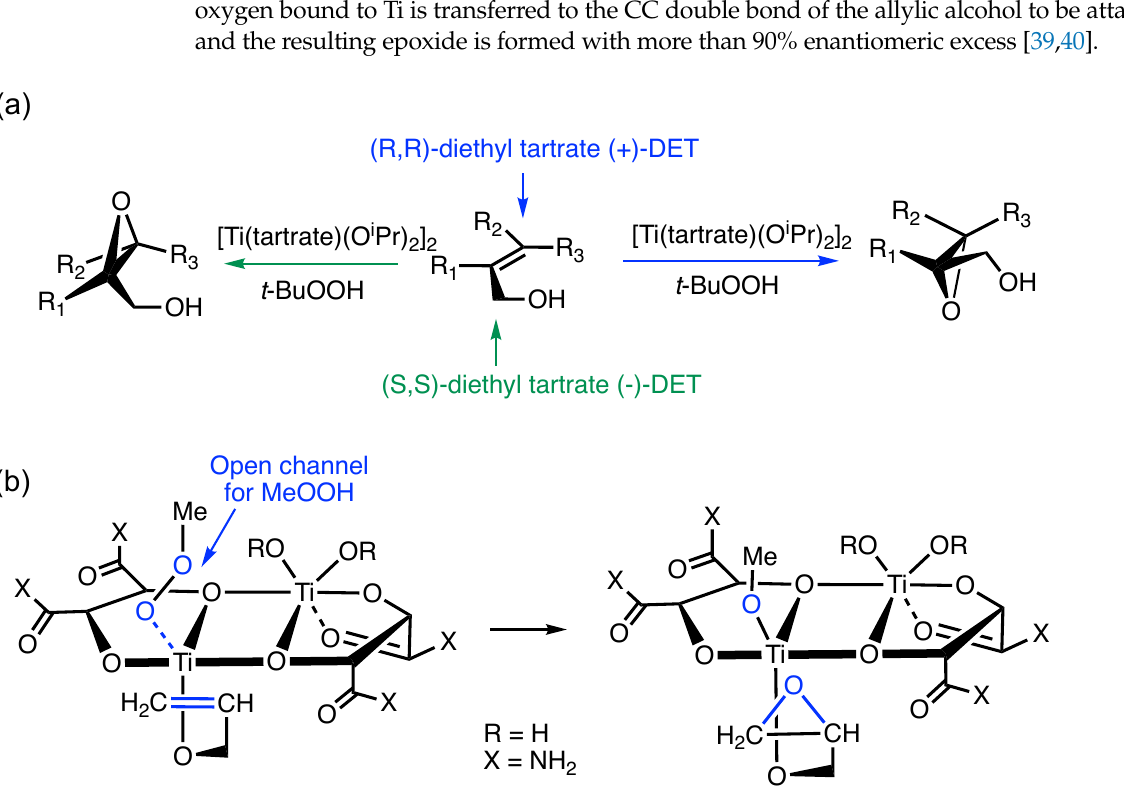
Figure 1. Sharpless asymmetric epoxidation ( a ) General scheme; ( b ) Dimeric Sharpless titanium(IV) model catalyst for the methyl–hydroperoxide oxidation of allylalcohol studied in this